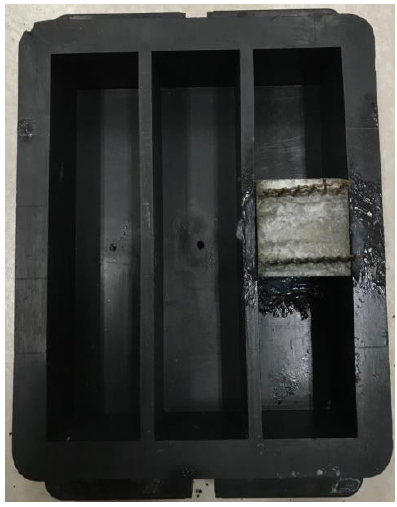
Figure 2. The tank used in permeating test.